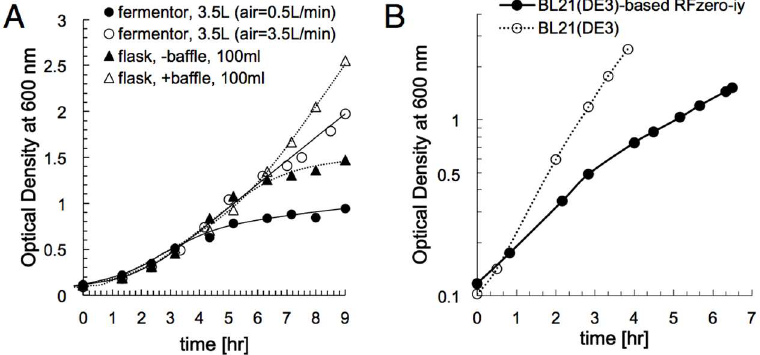
Figure 3. Growth profiles of RFzero-iy and BL21(DE3). ( A ) BL21(DE3)-based RFzero-iy was grown in a standard flask (filled triangles), a baffled flask (open triangles), and a jar fermenter with air supply rates of 0.5 L/min (filled circles) and 3.5 L/min (open circles). ( B ) BL21(DE3) (open circles) and BL21(DE3)-based RFzero-iy (filled circles), grown in jar fermenters at 30 °C.